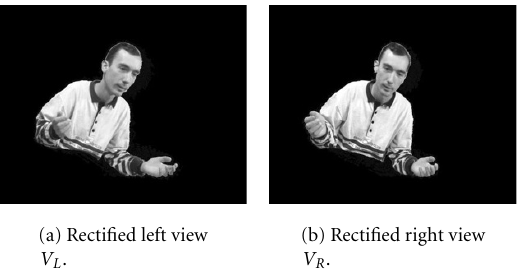
Figure 5: An example stereo pair from the cameras 1 and 2 of the VIRTUE setup as shown in Figure 10. Notice the large occlusion areas around the right arm of the participant and the converging e ff ect of the setup.